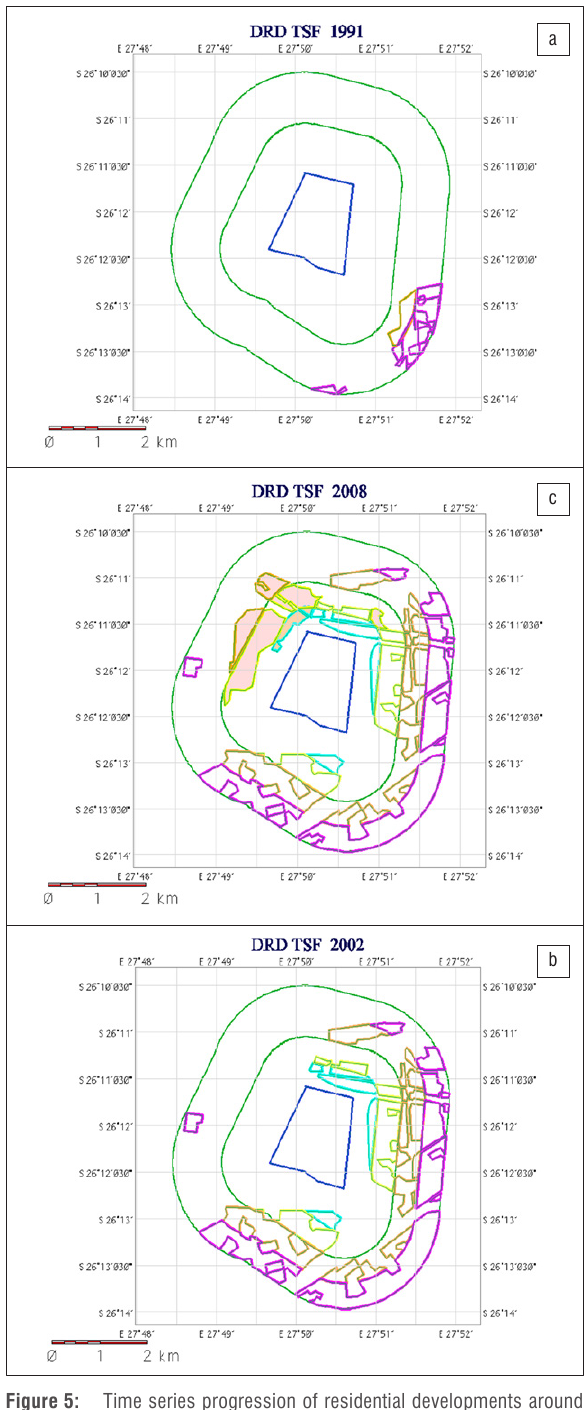
Figure 5: Time series progression of residential developments around the Durban Roodepoort Deep tailings storage facilities (inner blue polygon), with 1 km and 2 km buffer zones (dark green): (a) 1991; (b) 2002 and (c) 2008, cyan ≤ 500 m; yellow between 500 m and 1 km; orange between 1 km and 1.5 km; cerise between 1.5 km and 2 km, purple = tailings storage facilities (TSF) footprints. Brown coloured polygons indicate where houses were being built in 2008.